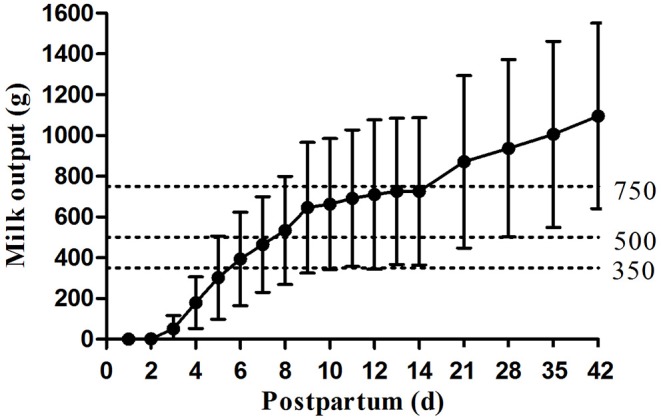
Daily maternal milk output in 1st 42 days postpartum.